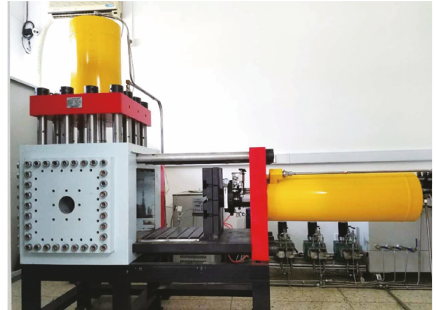
Figure 2: True triaxial hydraulic fracturing simulation test system (Ma et al.,